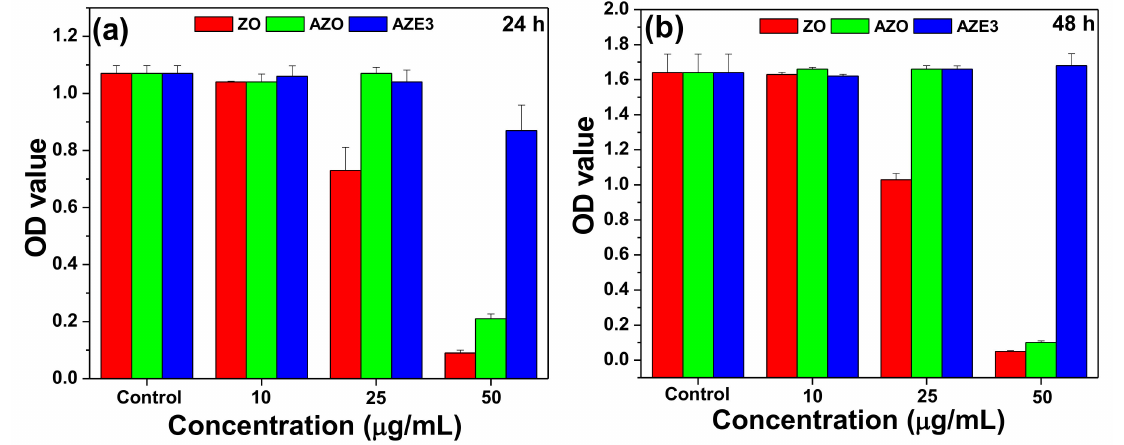
Figure 9. Cell viability from in vitro cellular cytotoxicity, WST assay of 293 cells (human embryonic kidney cells) for ZO, AZO, and AZE3 samples with various concentrations for ( a ) 24 h and ( b ) 48 h. The error bars represent the ± standard deviation (SD) ( p <